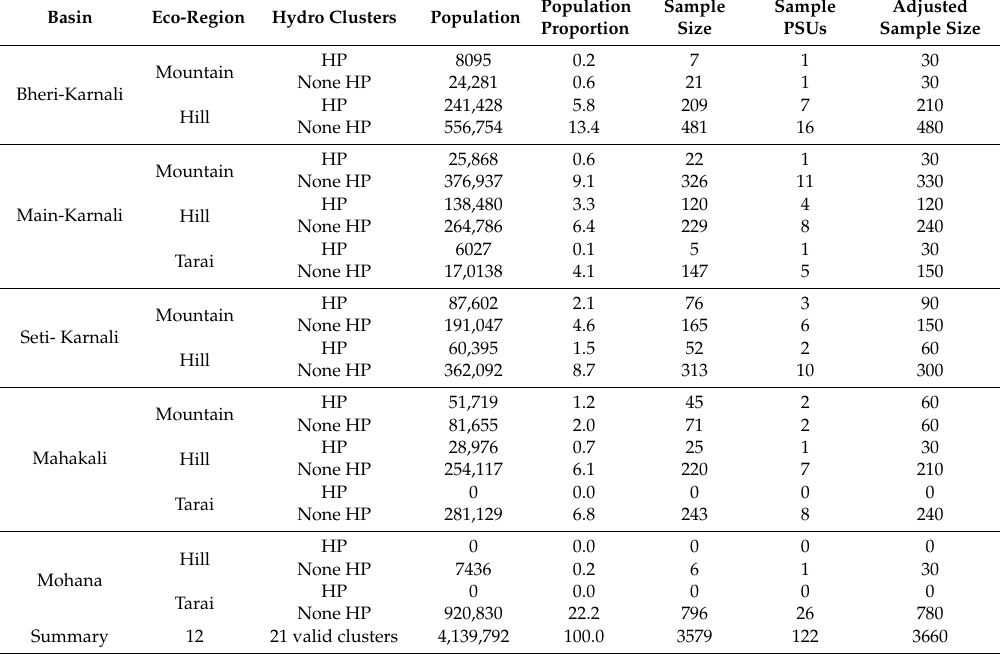
Table A1. Selected sample size by PSUs. HP is hydropower. PSU is primary sampling unit.